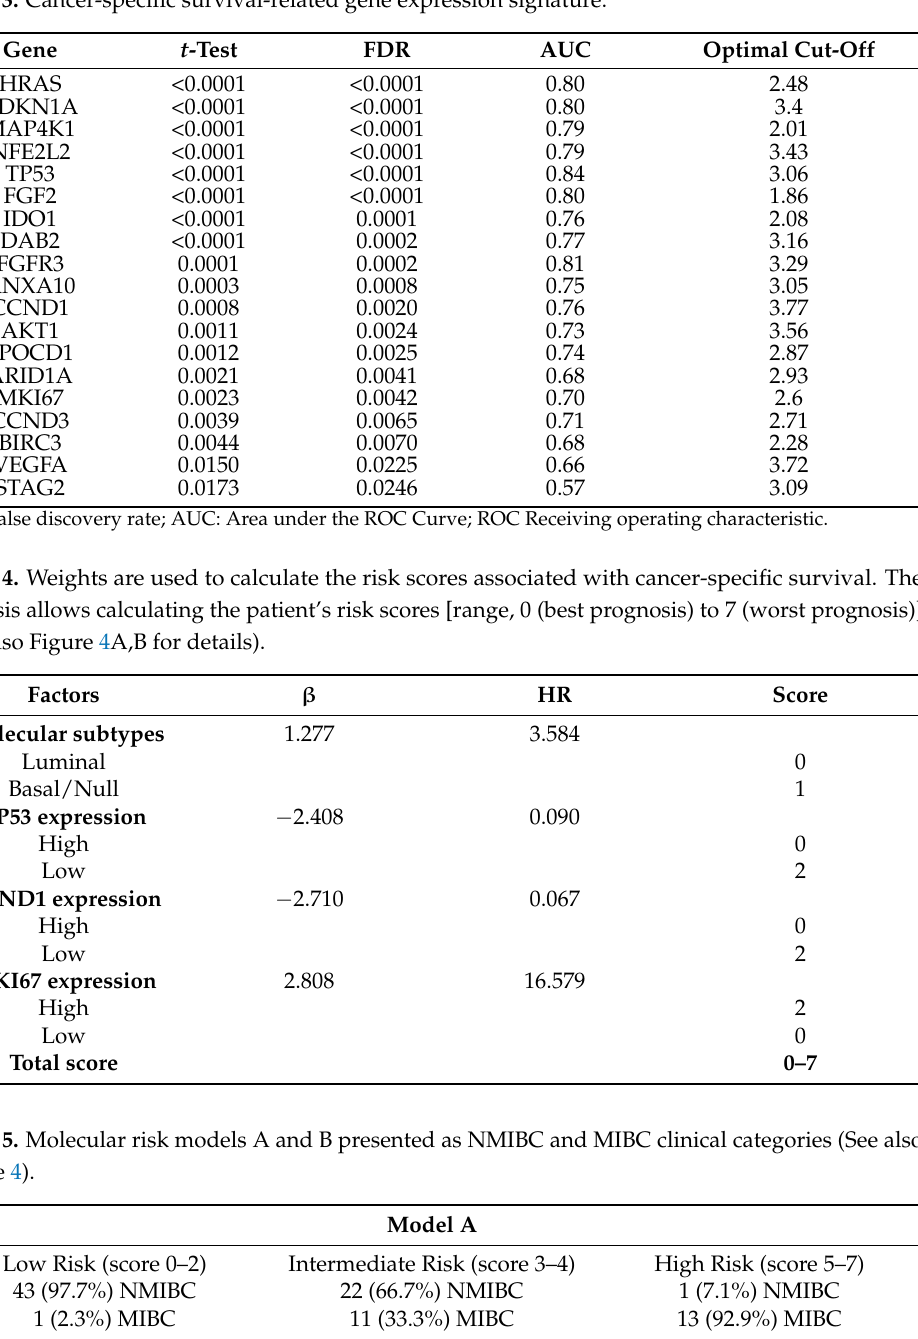
Table 3. Cancer-specific survival-related gene expression signature.